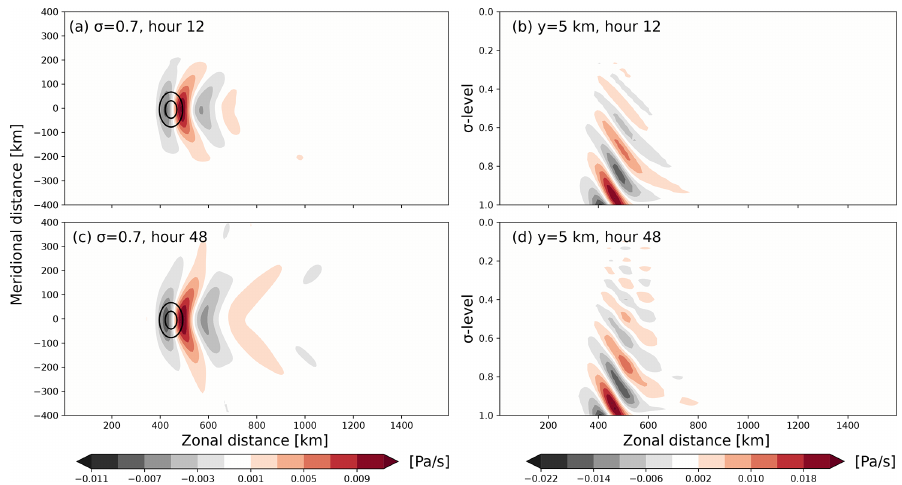
Figure 9. Developing stationary inertia–gravity wave response to orographic forcing on an f plane for full PE. The left column (a, c) shows the horizontal wave pattern at σ = 0 . 7. The right column (b, d) shows the vertical wave propagation in the x – z plane at y ≈ 0. From top to bottom, the rows show the development after (a, b) 12h and (c, d) 48h. The shading shows the pressure vertical wind (in Pas − 1 ), the contours show the orography by the 4 and 8m contours. Note that the entire model domain is not shown in the y direction.